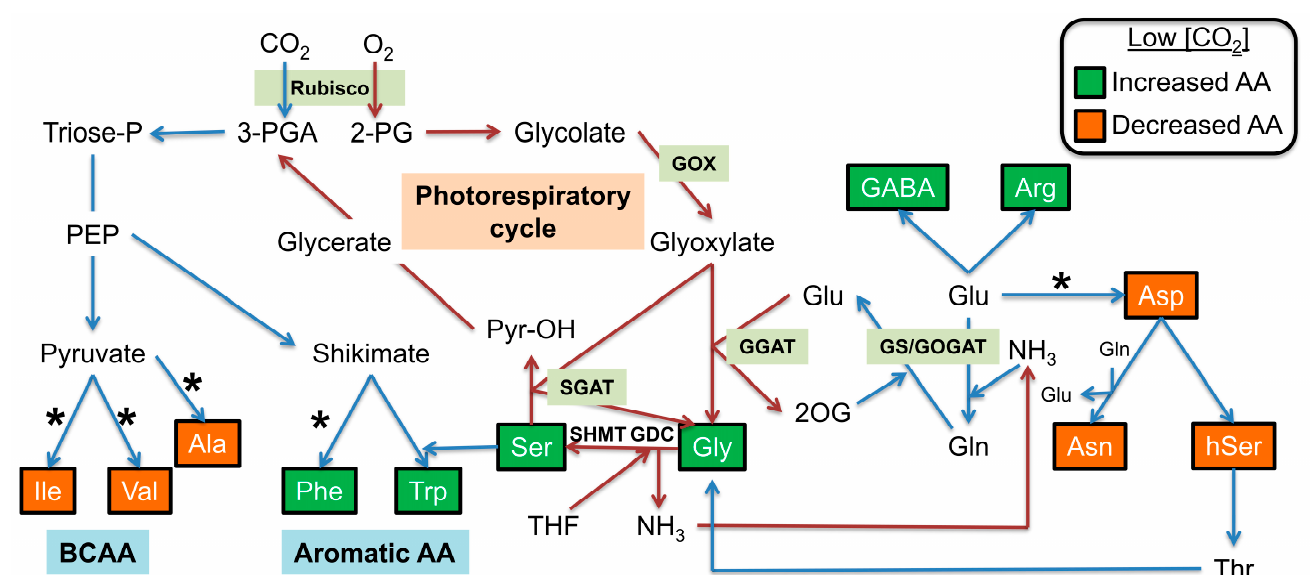
Figure 5. Simplified metabolic scheme highlighting low-CO 2 induced changes in amino acids. In low CO 2 conditions, Rubisco oxygenase activity is increased at the expense of Rubisco carboxylase activity. This led to increased (green boxed) and decreased (orange boxed) soluble amino acid levels in Arabidopsis rosette leaves. Photorespiratory NH 3 is reassimilated to produce Glu via the GS/GOGAT cycle and this Glu is recycled by the glutamate:glyoxylate aminotransferase (GGAT). Glyoxylate produced by glycolate oxidase (GOX) is a common substrate of GGAT and the serine:glyoxylate aminotransferase (SGAT). * Indicates Glu-dependent aminotransferases involved in amino acid biosynthesis pathways. Other abbreviations: 2OG, 2-oxoglutarate; 2-PG, 2-phosphoglycolate; 3-PGA, 3-phosphoglycerate; AA, amino acids; BCAA, branched-chain amino acids; GDC, glycine decarboxylase; GOGAT, Gln:2-oxoglutarate aminotransferase; GS, glutamine synthetase; PEP, phosphoenolpyruvate; Pyr-OH, hydroxypyruvate; Rubisco, ribulose-1,5-bisphosphate carboxylase/oxygenase; SHMT, serine hydroxymethyl transferase; THF, tetrahydrofolate; Triose-P, triose-phosphates.